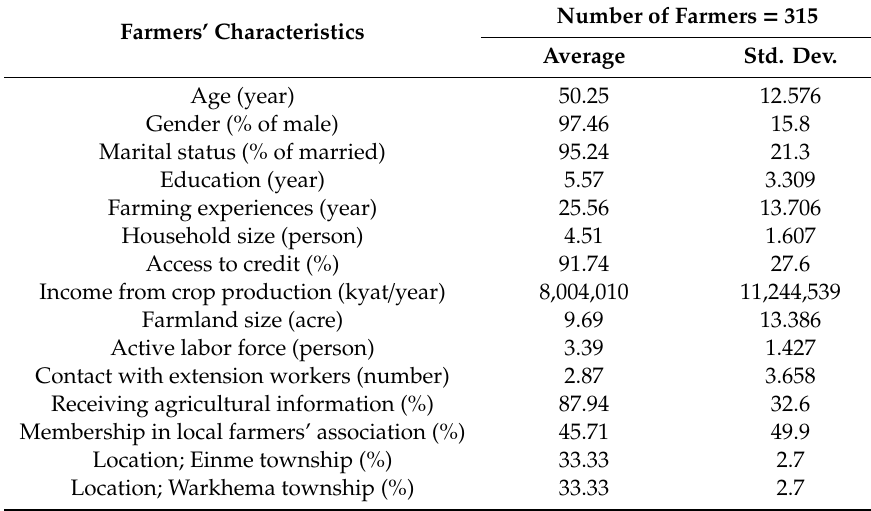
Table 4. Descriptive summary of farmers’